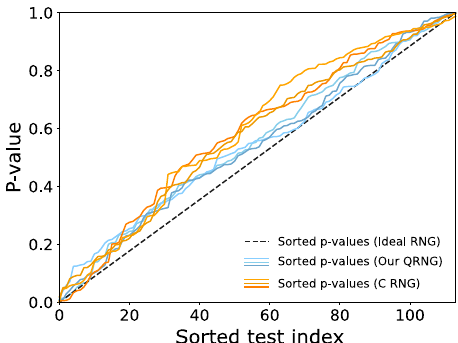
Fig. 2 Statistical evaluation. We evaluate the (statistical) randomness of bits produced by our quantum random number generator. Data generated in laboratory setup passes all tests in the “ Dieharder ” suite (i.e., 0.01 < p < 0.99), illustrated here in the form of the KS test 42 (blue curves) alongside a hypothetical ideal randomness source (black dashed line) and pseudorandom numbers generated using C RNG (yellow curves). This qualitative test sorts p values and plots them alongside values uniformly distributed over the interval [0,1].